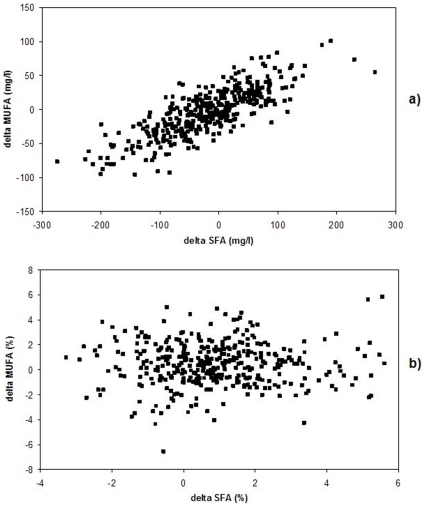
Changes of total monounsaturated fatty acids between 2 and 6 years (delta MUFA, mg/l) show a high correlation (r = 0.79) with changes of total saturated fatty acids (delta SFA, mg/l) (a), while changes of corresponding percentage values (%) are unrelated (b, r = −0.02).